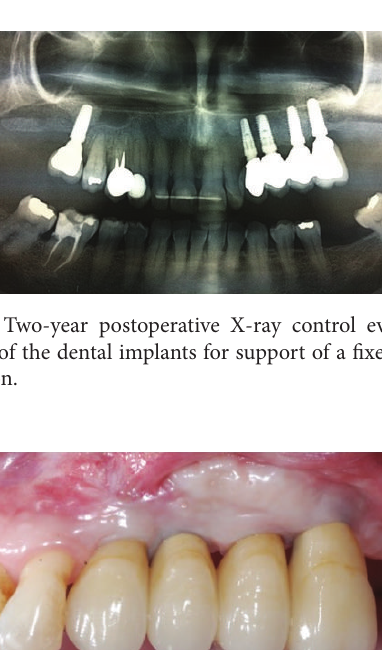
Figure 11: Histological image 40x magnification underlines the presence of new bone cells and some residual particles of the sub- stitute material.